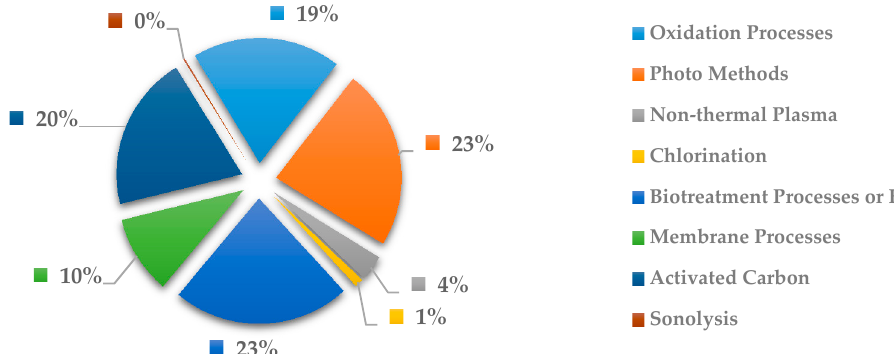
Figure 27. Percentage of scientific articles worldwide regarding wastewater treatments of cardiovascular drugs between 1998 and 2020. Data collected in Scopus database by using wastewater or water as keywords and English as a language limitation.